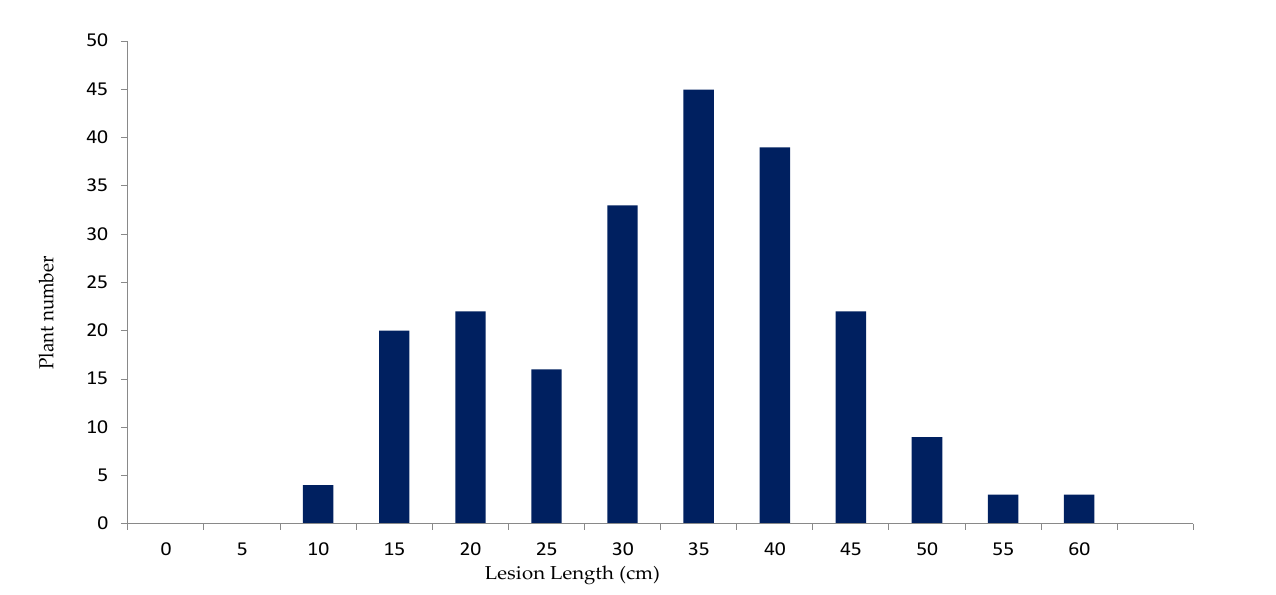
Figure 2. Frequency distribution of lesion length after inoculating with Xoo Race II (strain T7147) using leaf-clipping method after 18 days in the F 2 population ( n =216) derived from the cross between KO and AR. Three leaf measurements from each plant were recorded. An average of three leaves was used as a phenotypic characteristic.